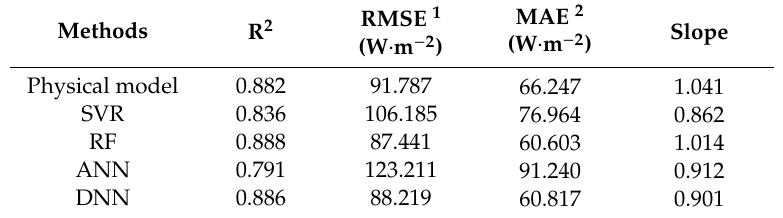
Table 4. Statistical performance of selected models determined by five-fold